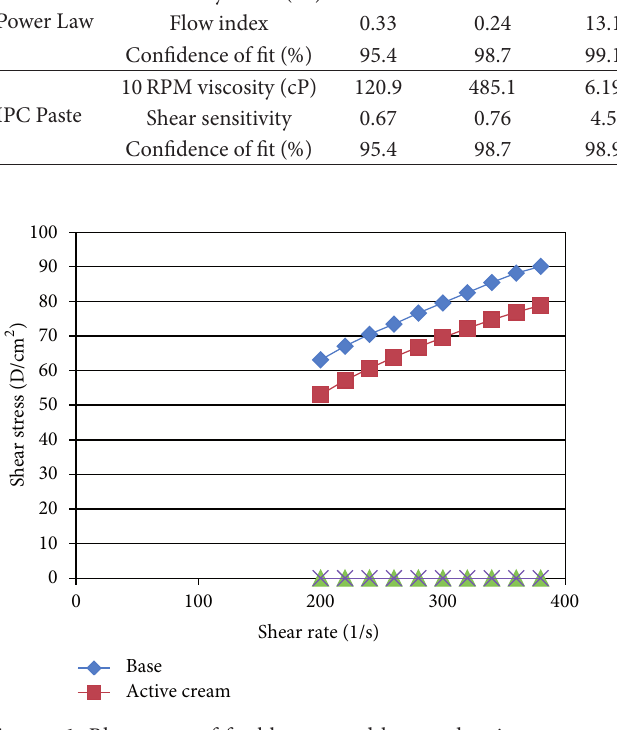
F 1: Rheograms of freshly prepared base and active cream. C. F 2: Rheograms of base at four weeks kept at Analyses were performed at 25 ∘